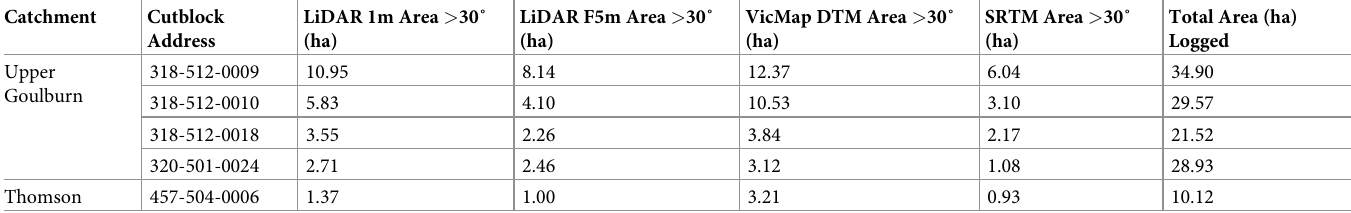
Table 3. Sample of cutblocks calculated with slopes > 30˚ logged using LiDAR at 1 m resolution (LiDAR 1m), LiDAR with a 5m (LiDAR F5m) average slope neigh- bourhood, the Shuttle Topography Radar Mission (STRM) at a 1 arc second resolution, and the VicMap Elevation DTM (DTM) at 10m resolution. These cutblocks were measured by the authors and also by staff from the OCR.